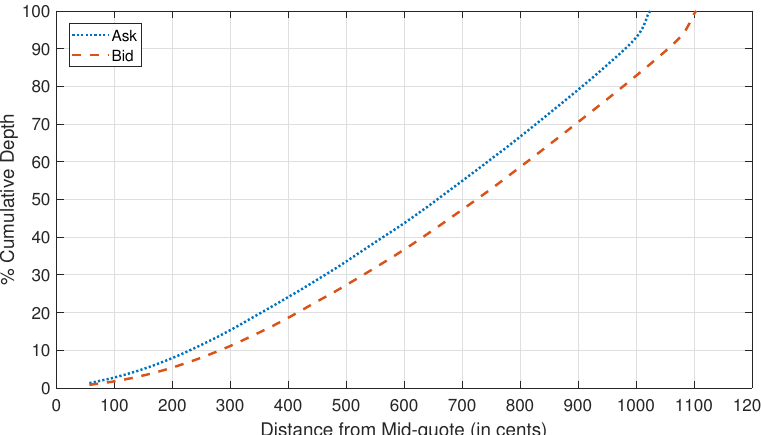
Figure 7. The figure plots the average slope of the bid and the ask side of the limit order book. The x -axis shows the price distance from the best bid-ask midpoint in cents. The y -axis shows the percent of cumulative depth at each price increment. Data are from BTC-e for the period from 7 December 2013 to 24 September